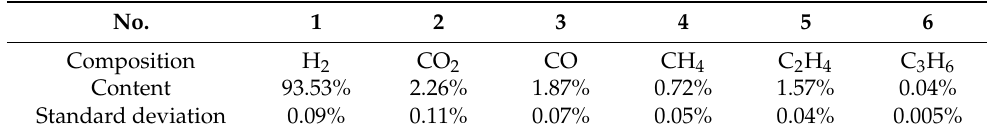
Table 4. Composition and content of gas product by Ar/H 2 -plasma pyrolysis. No.